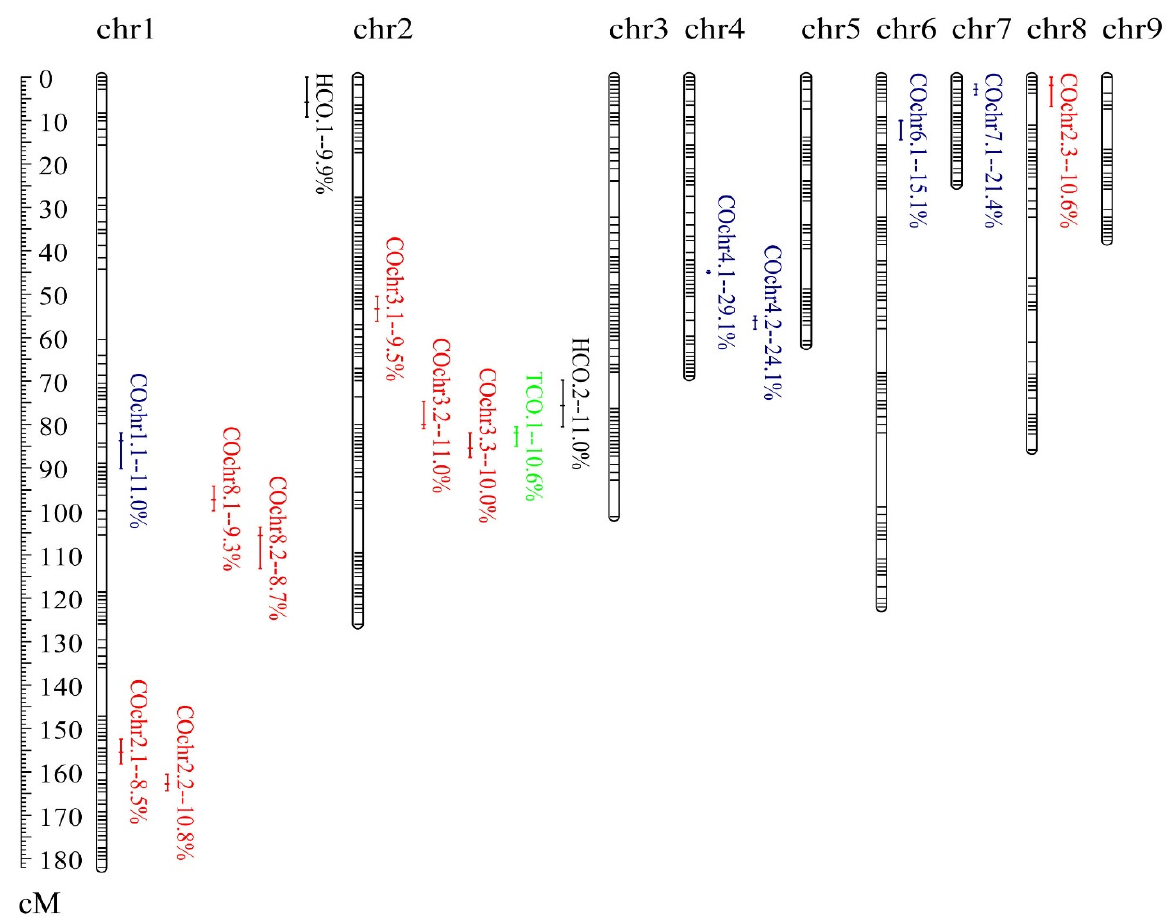
Figure 2. Distribution of QTLs for crossover variation in L. edodes . This Lemap2.0 was generated previously [15]. Sixteen QTLs for crossovers were shown on the right side of the chromosomes. The LOD-1 confidence interval was indicated by the length of the QTL bar, and the position of the LOD peak was represented by the short line in the middle of the QTL bar. The percentage value is represented the R 2 value (percentage of explained phenotypic variation). The cis-prone QTLs are marked in blue, while trans -QTLs are in red. QTLs for HCO and TCO are marked in black and green, respectively. Table 1. QTLs for crossover variation of L. edodes.